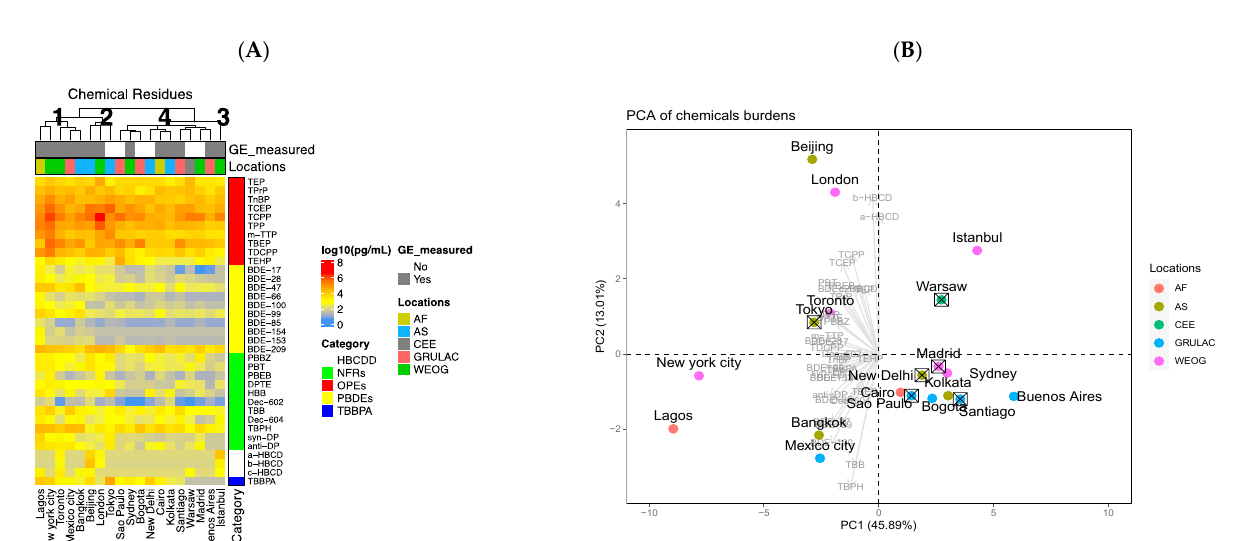
Figure 2. Total concentrations (log 10 [pg/mL]) of organic flame retardants (OFRs), including organophosphate esters (OPEs), polybrominated diphenyl ethers (PBDEs), novel flame retardants (NFRs), hexabromocyclododecanes (HBCDDs) and tetrabromobisphenol A (TBBPA), measured in PUF air samplers from 19 megacities of five global regions (details in Figure 1) depicted by ( A ) hierarchical clustering, where red and blue hues indicate high and low OFR concentrations, respectively, and the grey boxes identify sites for which gene expression data were collected; and ( B ) principal component analysis (PCA) of OFR loadings, where the most influential OFRs are depicted by arrows on the graph.